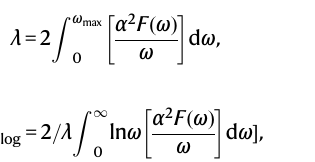
Fig.2|OrbitaldependentEPC.a ContoursoftheFSsandthemomentumlocation ofthecutsshownin( b ). b ARPESintensityplotsthe α and β bands.Themomentum is rescaled with respect to their k F. c Extracted band dispersions of the α and β bands. The arrows show the energy position of the kinks. The black lines are the correspondingbarebands. d ExtractedRe Σ ( ω )ofthe α and β bands.Theerrorbars for Re Σ ( ω ) are determined from standard deviation of the MDC fi ts, which is